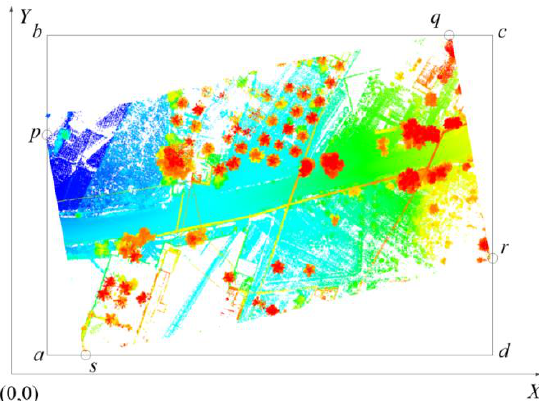
Figure 1. Minimum bounding rectangle of input MLS